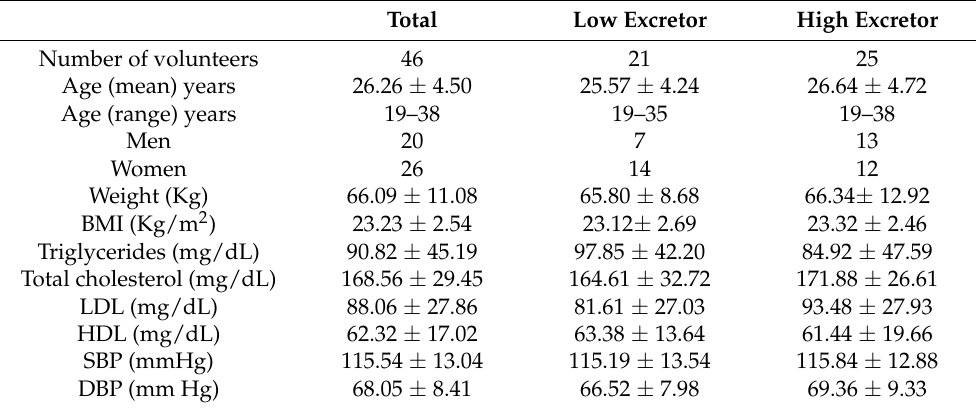
Table 2. Clinical and anthropometric characteristics of the population.